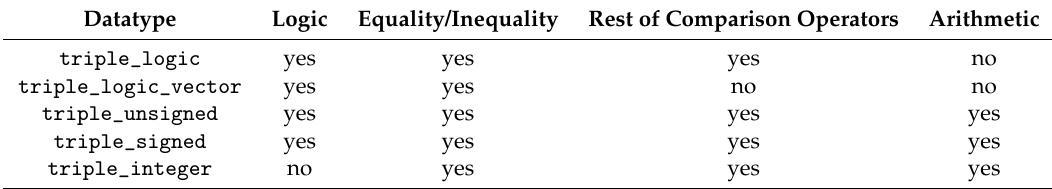
Table 2. List of implemented operators.